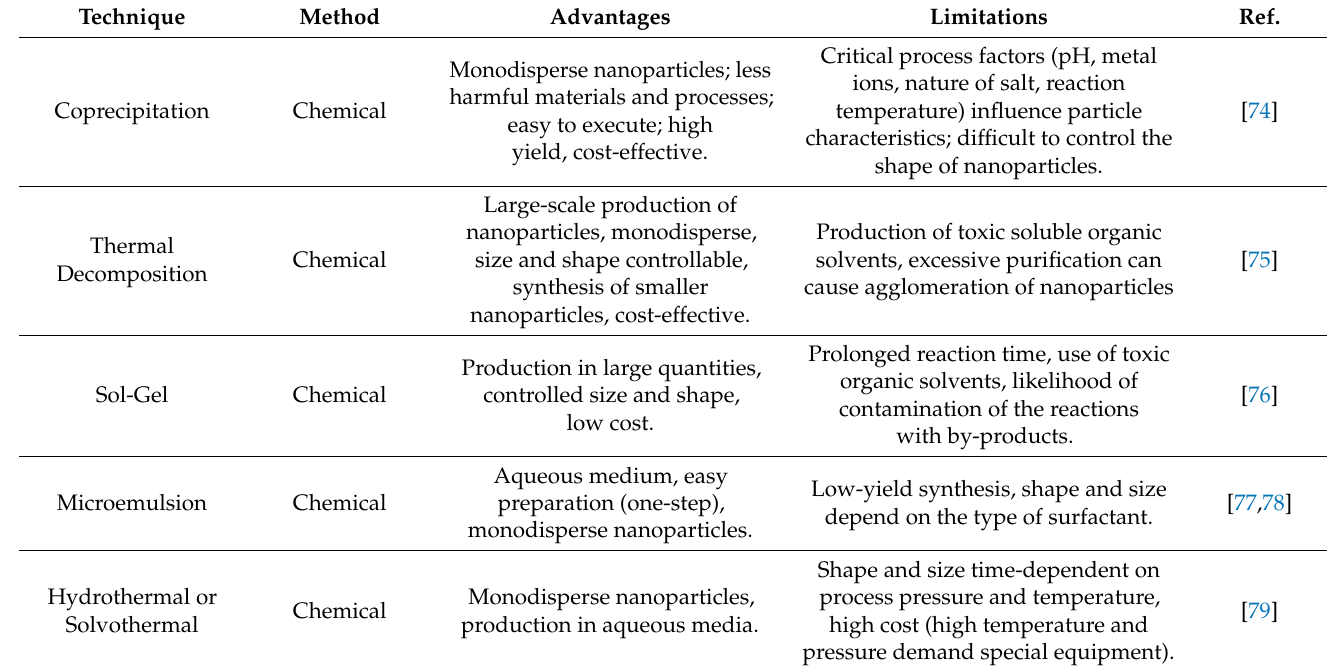
Table 2. Advantages and limitations of different MNPs preparation